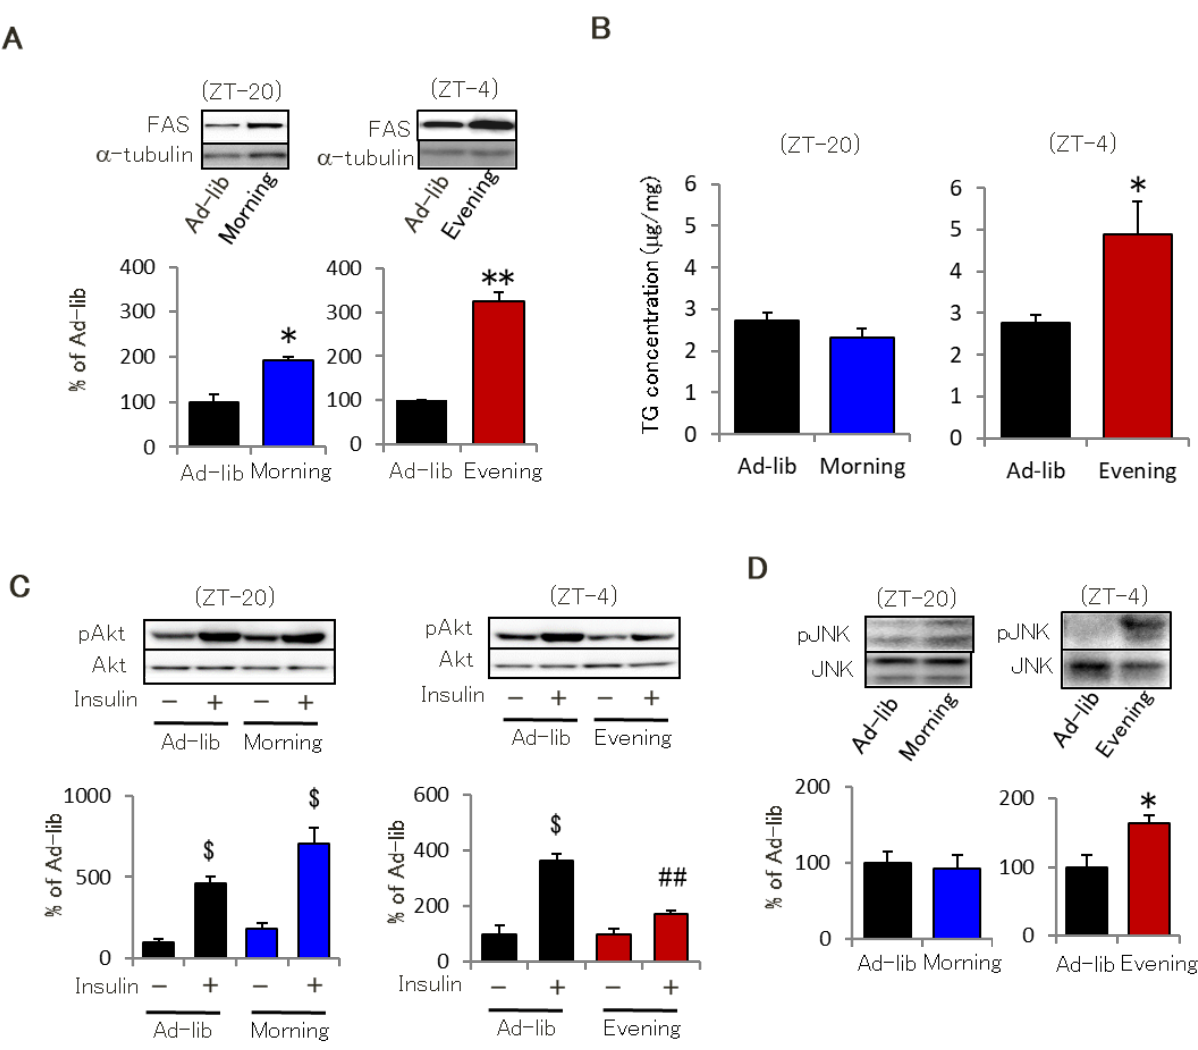
Figure 2. Evening feeding leads to skeletal muscle insulin resistance. ( A ) FAS expression in soleus muscle ( n = 4). ( B ) TG content in gastrocnemius muscle ( n = 6 – 8). ( C ) Akt phosphorylation in soleus muscle with or without insulin injection ( n = 3 – 4). Insulin was injected at same time point of ITT. ( D ) JNK phosphorylation in the soleus ( n = 3 – 4). Data are presented as mean ± standard error. * p < 0.05, ** p < 0.01 vs. Ad-lib group. $ p < 0.05 vs. Akt phosphorylation of each group without insulin. ## p < 0.01 vs. Ad-lib group (insulin +).